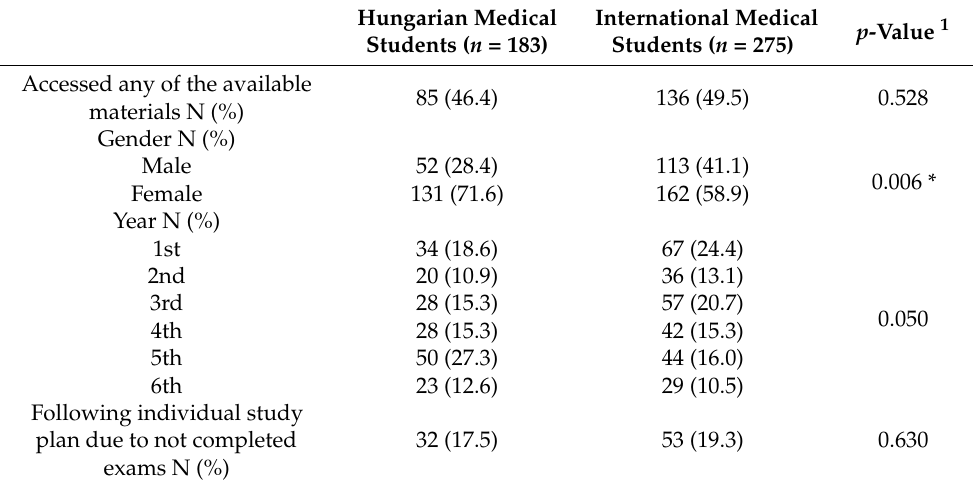
Table 1. Demographic characteristics of medical students using the services between 15 April 2020 and 15 April